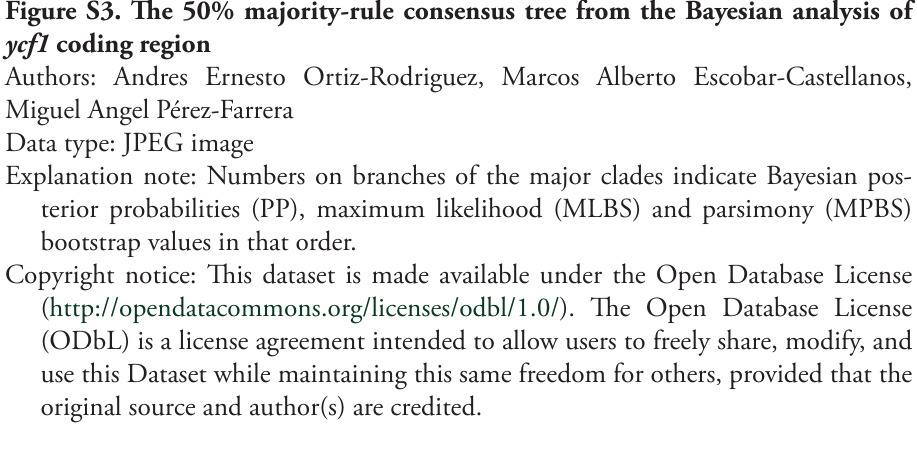
Figure S3. The 50% majority-rule consensus tree from the Bayesian analysis of ycf1 coding region